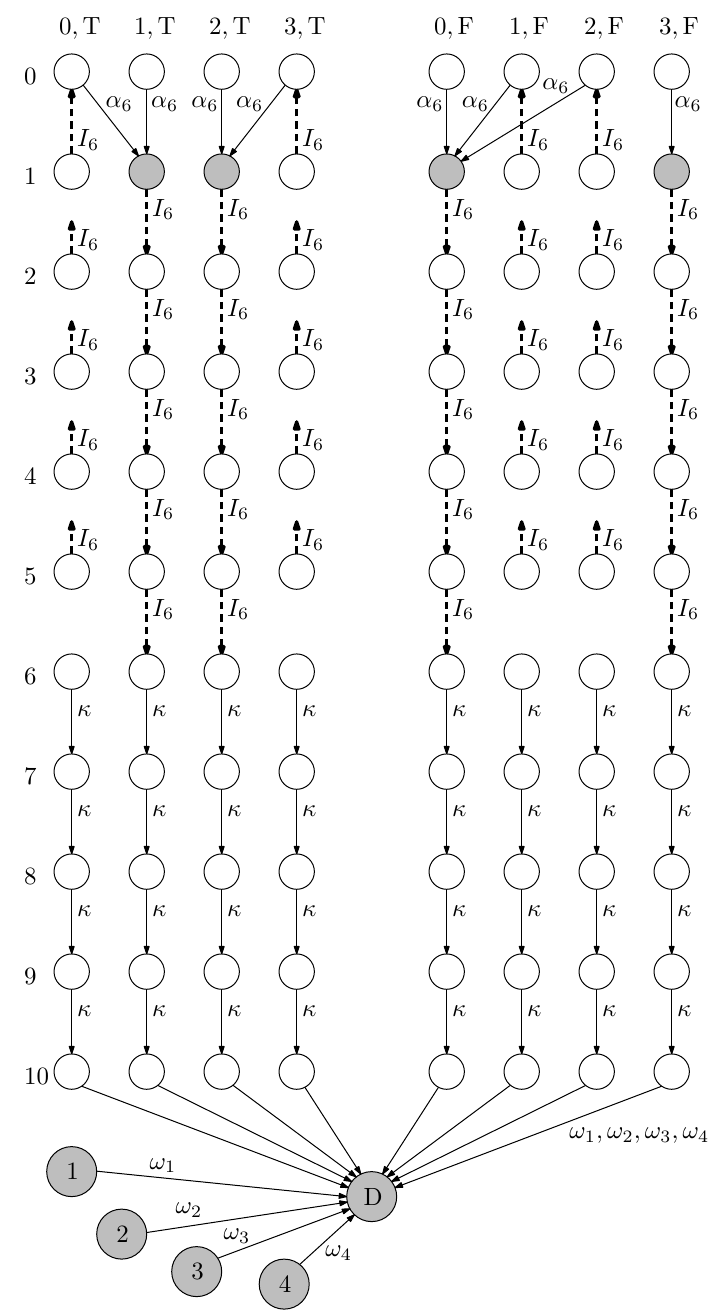
Fig. 1: Some transitions of the example automaton described in Sec. 3.4. Grey states remain active after applying α 6